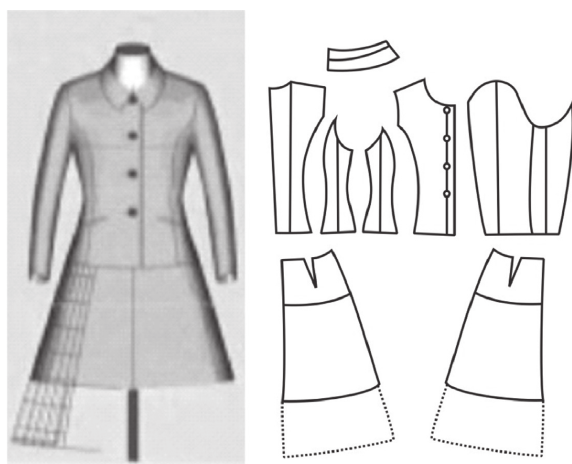
Figure 9: Transformation of 2D prototypes into a 3D garment in a virtual